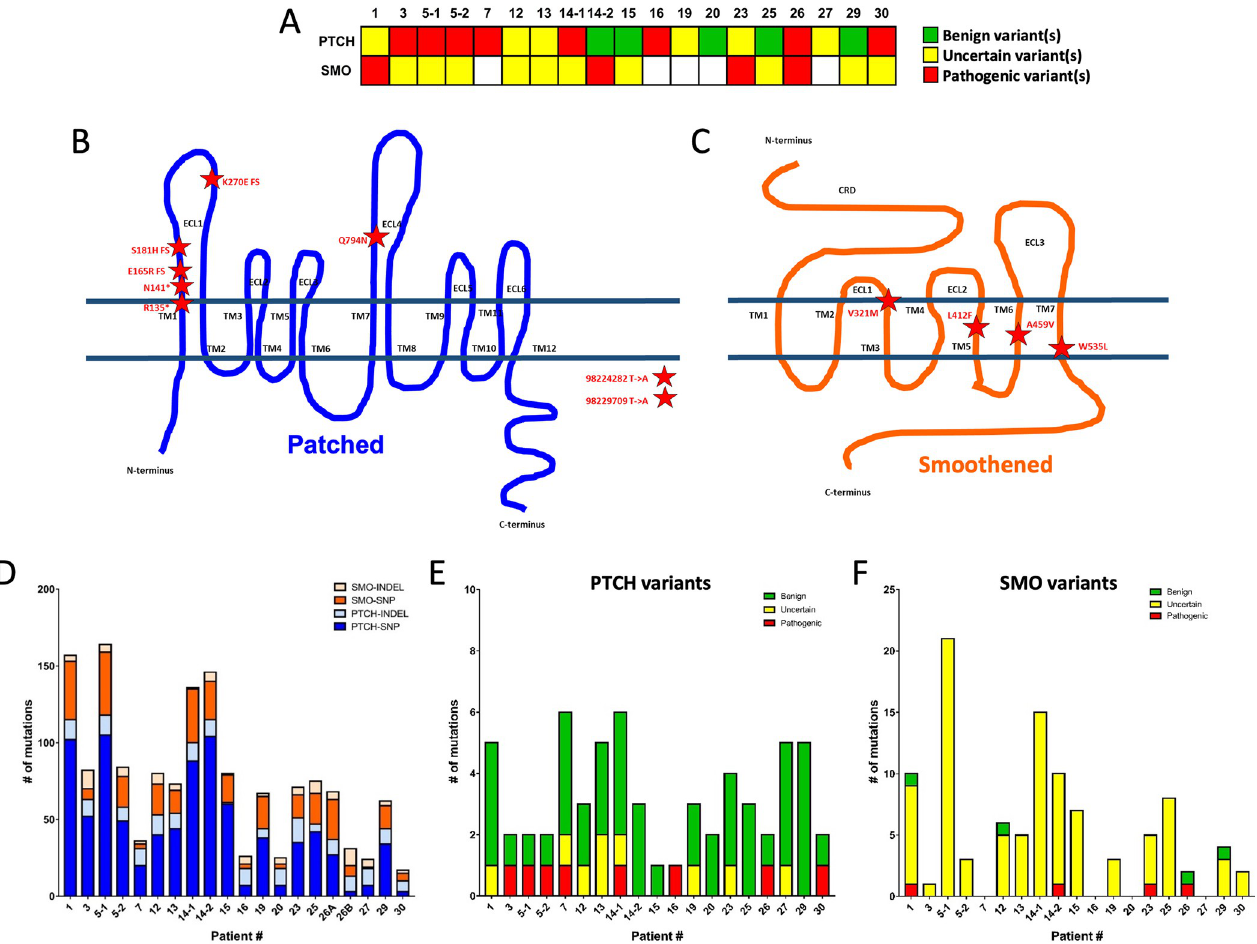
Fig 3. Mutational status of pre-vismodegib orbital BCC tumors. A) Summary of all PTCH and SMO variants present in each tumor. Schematic of PTCH (B) and SMO (C) pathogenic variants present in patient cohort. D) Summary of variant data by patient, E) Classification of non-silent PTCH variants with > 0.25 allele frequency, F) Classification of non-silent SMO